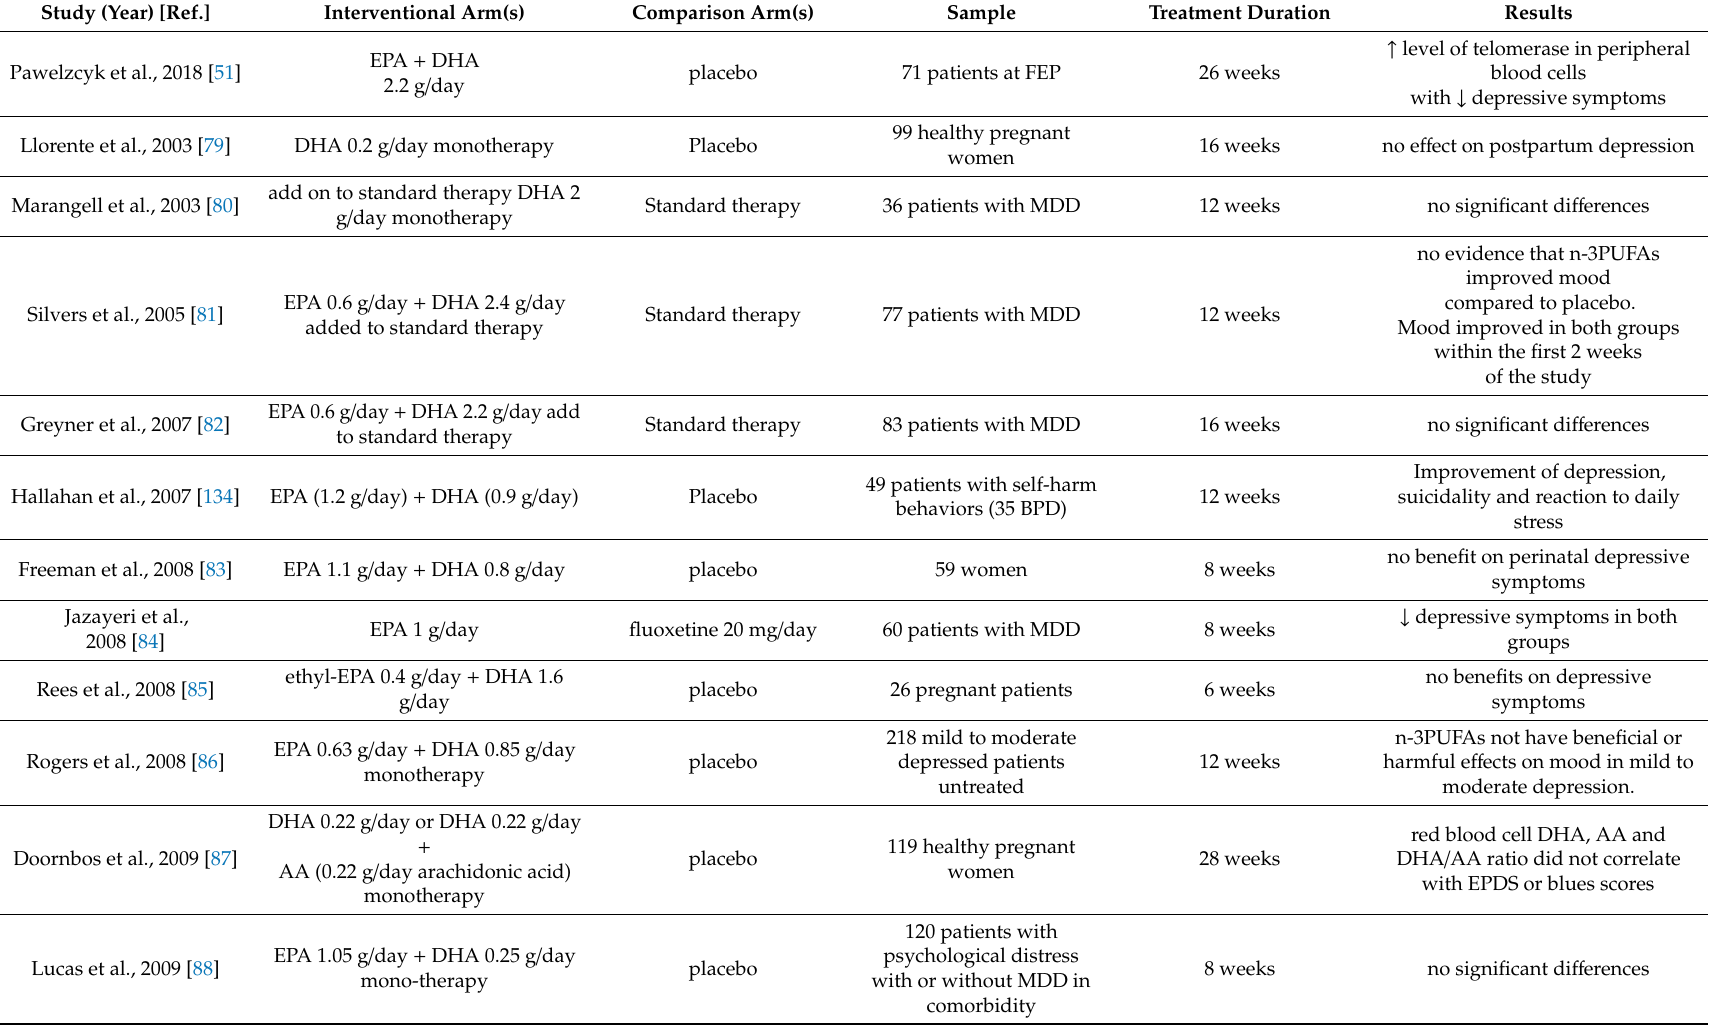
Table 2. Randomized controlled trials and open trials of omega-3 PUFAs on a ff ective